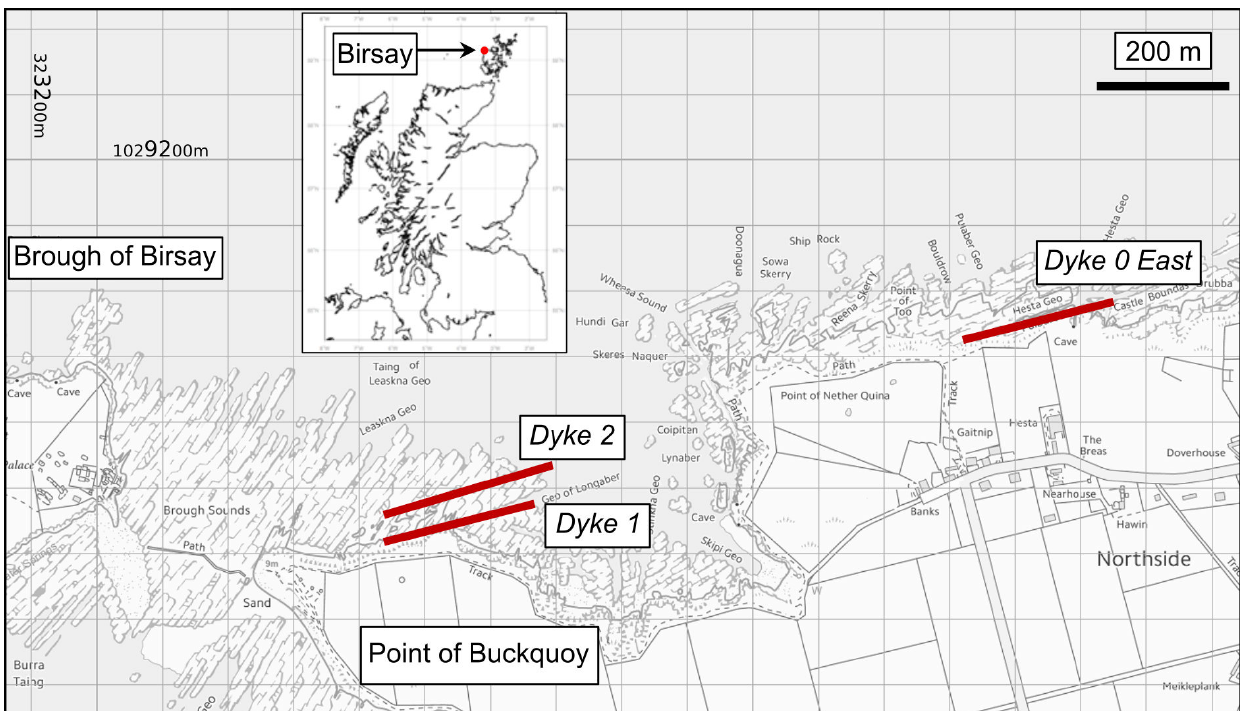
Figure 2: Details of the study area at Birsay, Orkney (UK). Inset map shows the location of Birsay at the NW corner of the Mainland of Orkney, o ff the north coast of Scotland. Main map shows the locations of the three dykes studied in detail in this paper. Excellent exposures are found in the wave cut platform to the north side of the Point of Buckquoy and at the top of the cli ff s beyond the houses at Northside. Dyke thickness exaggerated for clarity. Note that the segmentation of these dykes is not apparent at this scale. Background Ordnance Survey map from EDINA Digimap. © Crown copyright and database rights 2017 Ordnance Survey (Digimap